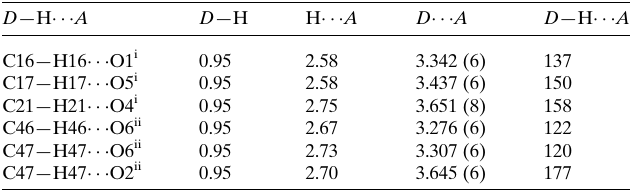
Table 2 Hydrogen-bond geometry (A˚ , (cid:4) ).